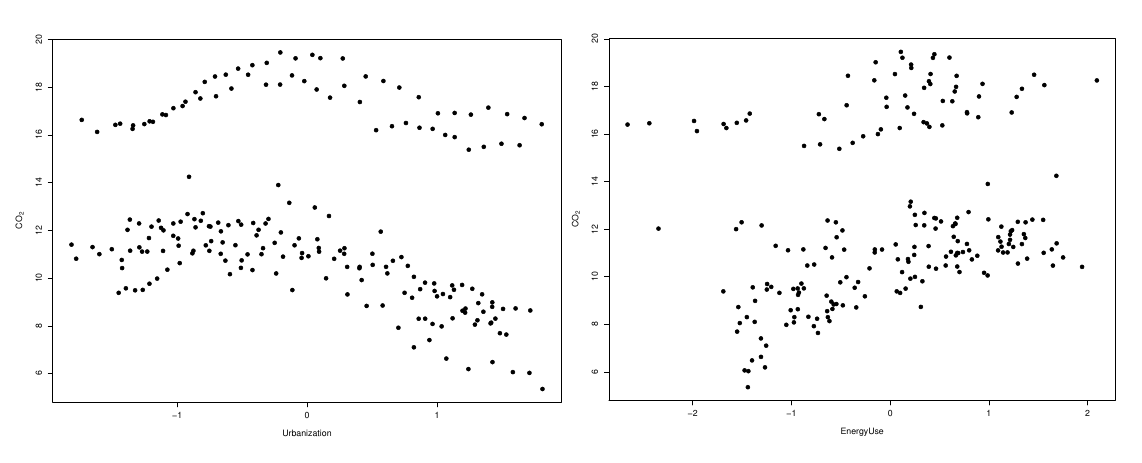
Figure 2. Scatter plots of climate data 1.